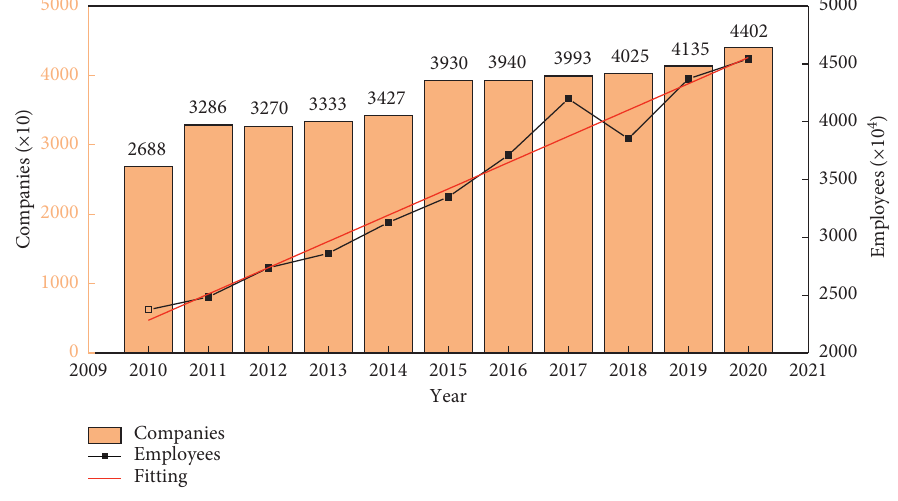
Figure 1: Relationship between enterprises and